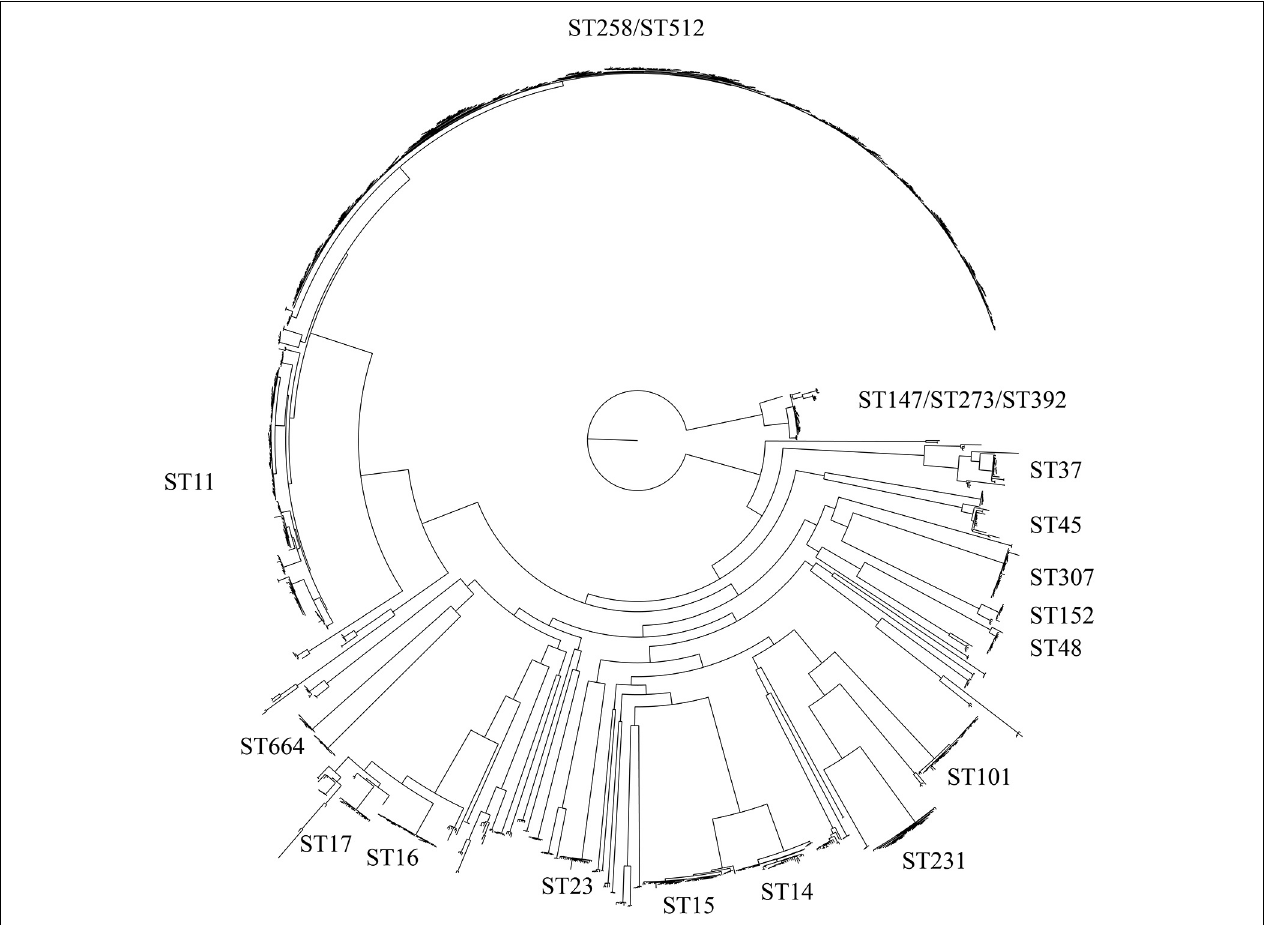
FIGURE 1 | Maximum-likelihood phylogeny of the Klebsiella pneumoniae species. This tree includes 1,724 genomes that collectively cover 38.59% of the GCA 001902435 reference genome and is based on 118,011 total SNPs. Within this species, several large clades exist and are labeled according to their MLST